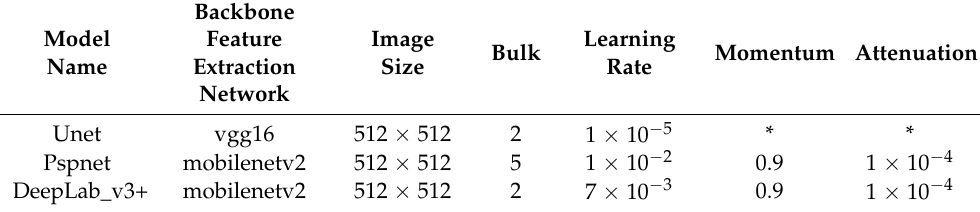
Table 3. Parameter setting of the